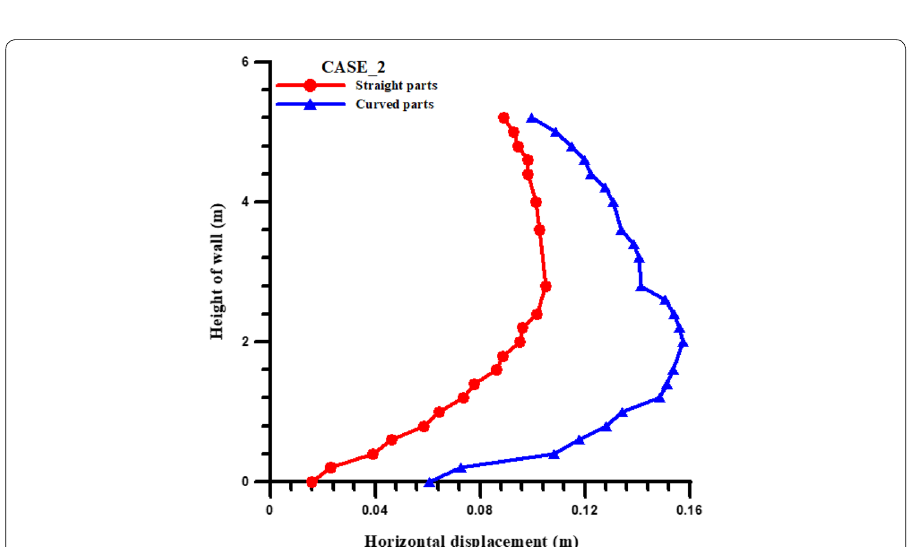
Fig. 12 Horizontal displacement comparison of straight and curved parts for Case